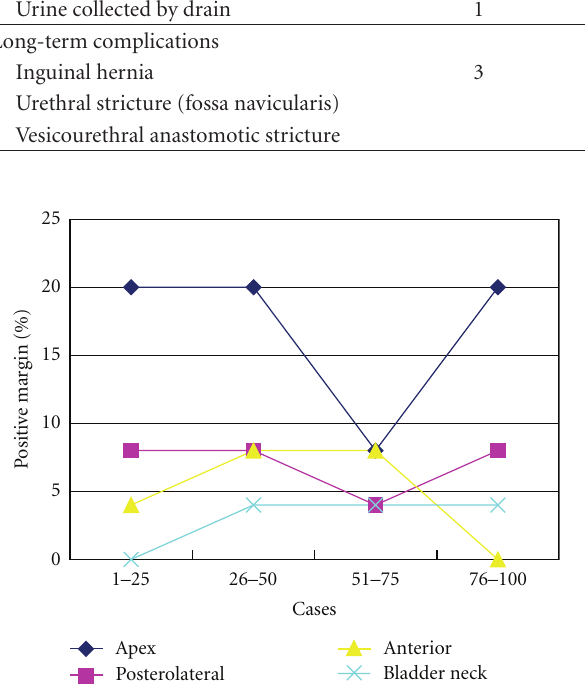
Figure 5: Percentage of positive surgical margins according to pT and number of cases operated on consecutively. The technique of apical dissection was modified after Patient